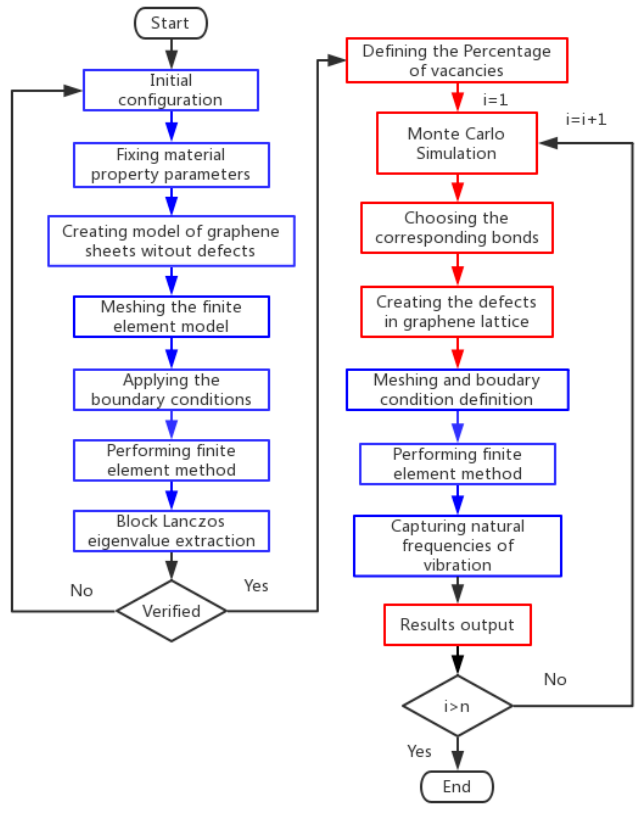
Figure 2. Flowchart of Monte Carlo based finite element method.